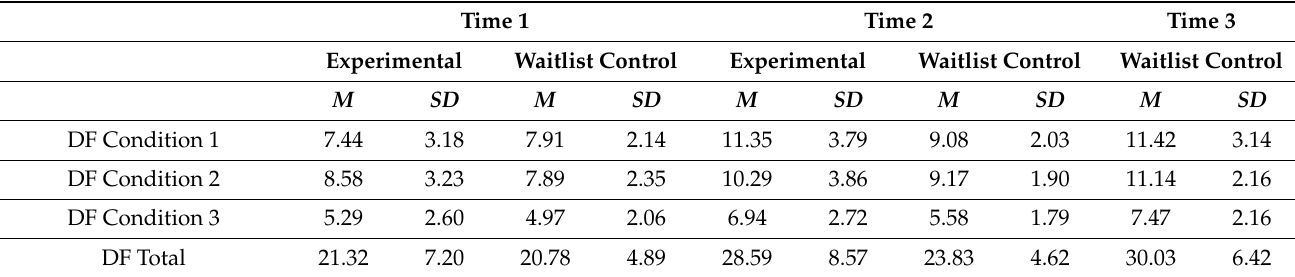
Table 1. Descriptive statistics for executive function scores (Study